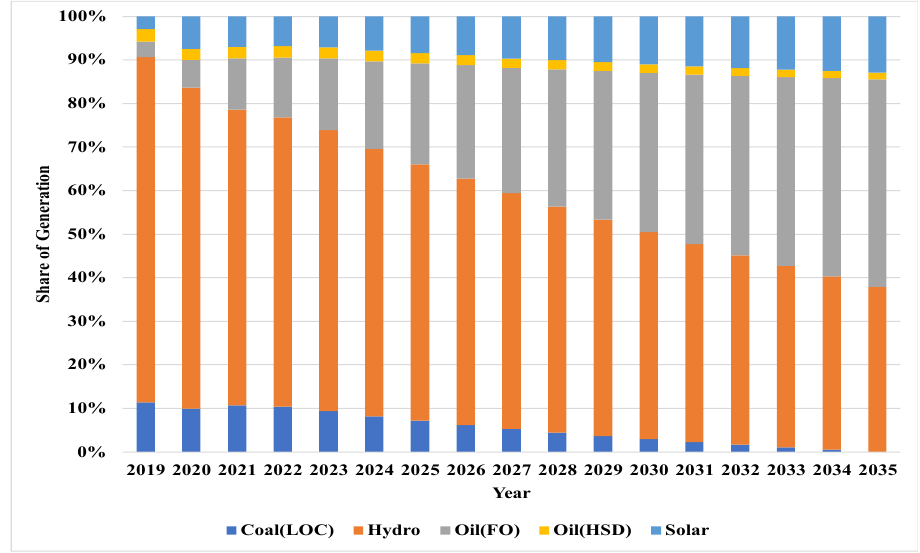
Figure 14. Power supply mix in the no coal scenario.